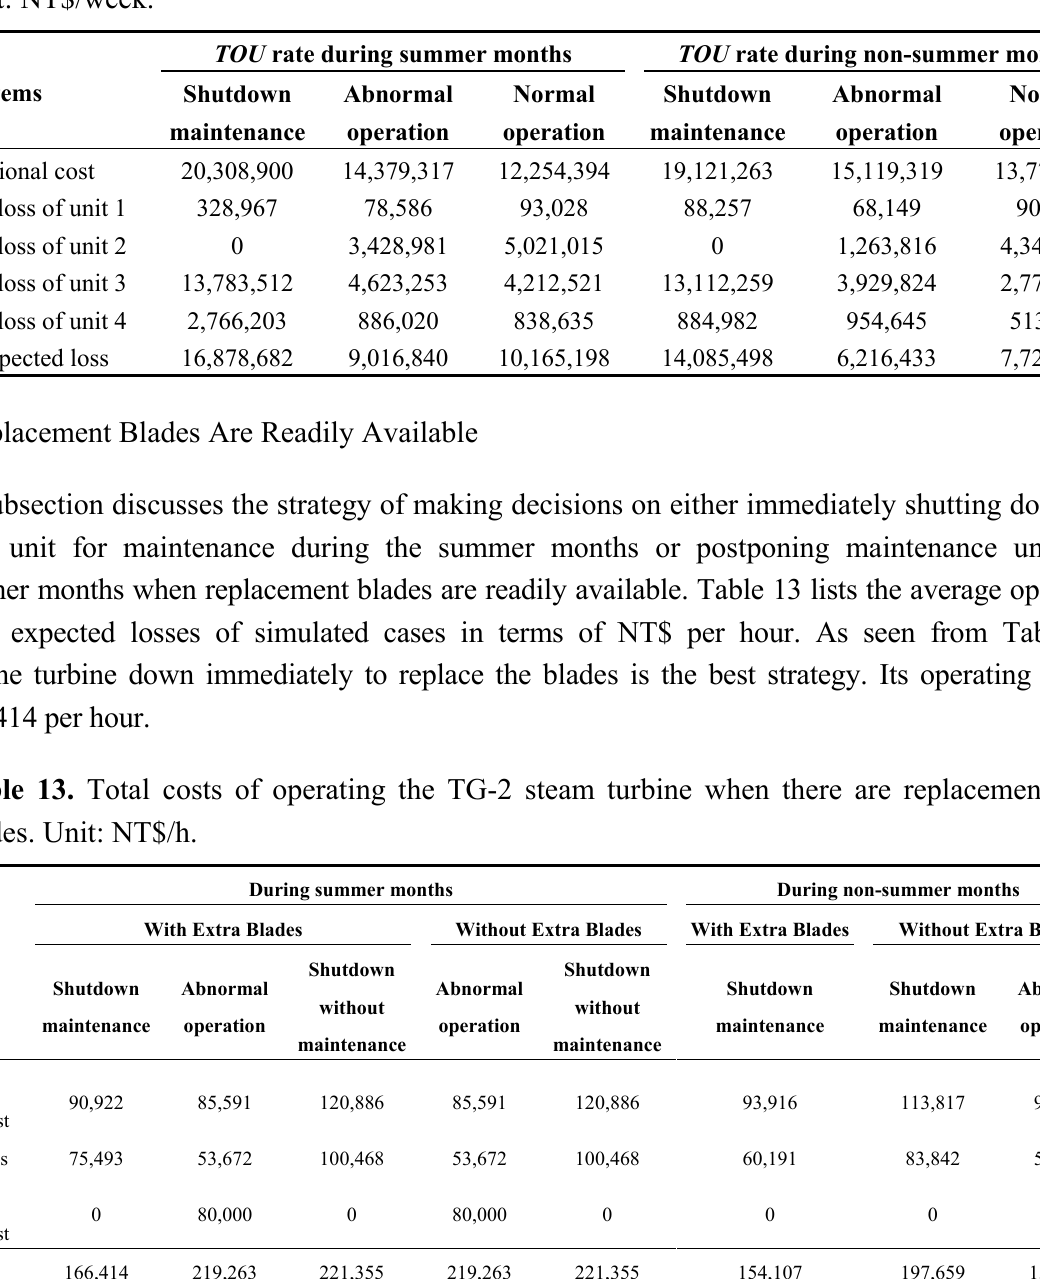
Table 12. Comparison of the operational costs and expected losses of different cases. Unit: NT$/week.